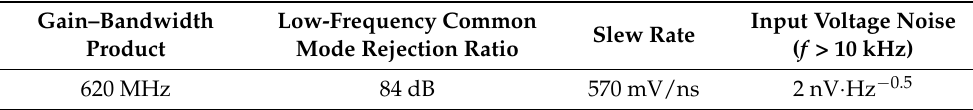
Table 7. Main characteristics of the operational amplifier THS4520RGTT.